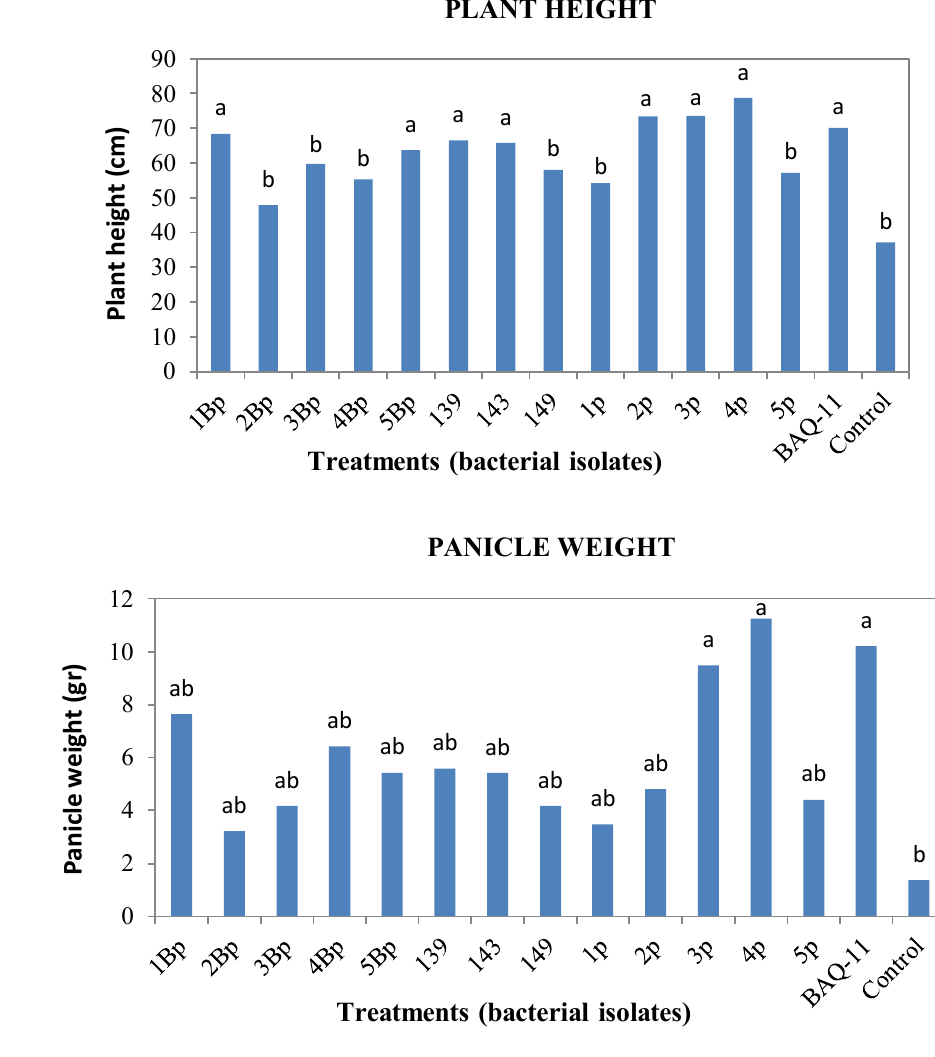
Figure 1. The results of ( a ) plant height and ( b ) panicle weight of eight-week-old quinoa plants treated with bacterial suspensions (10 8 cfu/mL) of different bacterial isolates are shown; control plants represent un-inoculated plants. Height and weight are measured in centimeters and grams, respectively; bacterial isolate identity: 1Bp, 2Bp, 3Bp, 4Bp and 5Bp ( B. pumilus ); 139, 143 and 149 ( B. simplex ); 1p, 2p, 3p, 4p and 5p ( Paenibacillus sp . ); BAQ-11 ( B. subtilis )